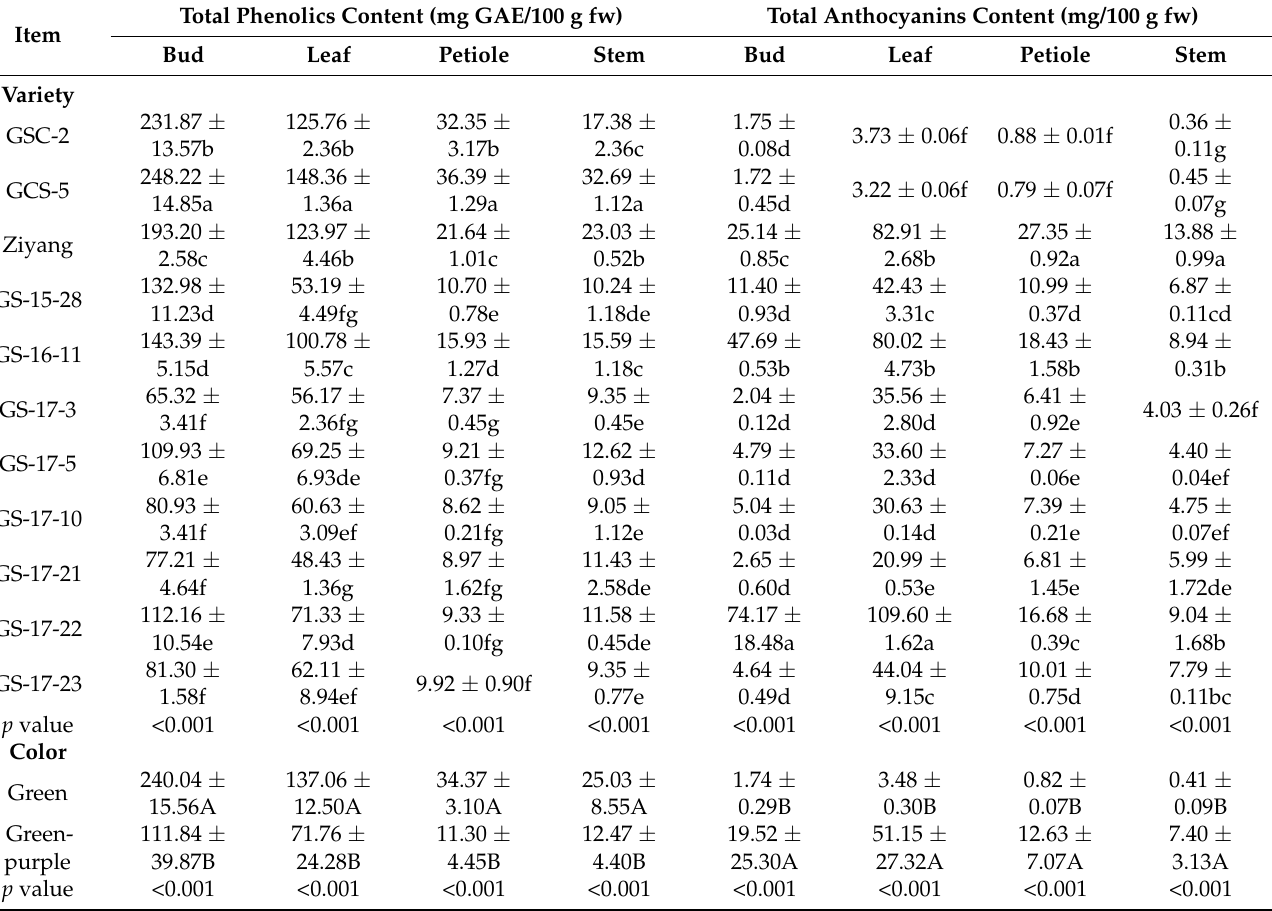
Table 1. Total phenolics content and total anthocyanins content of buds, leaves, petioles, and stems of 11 leafy sweet potato